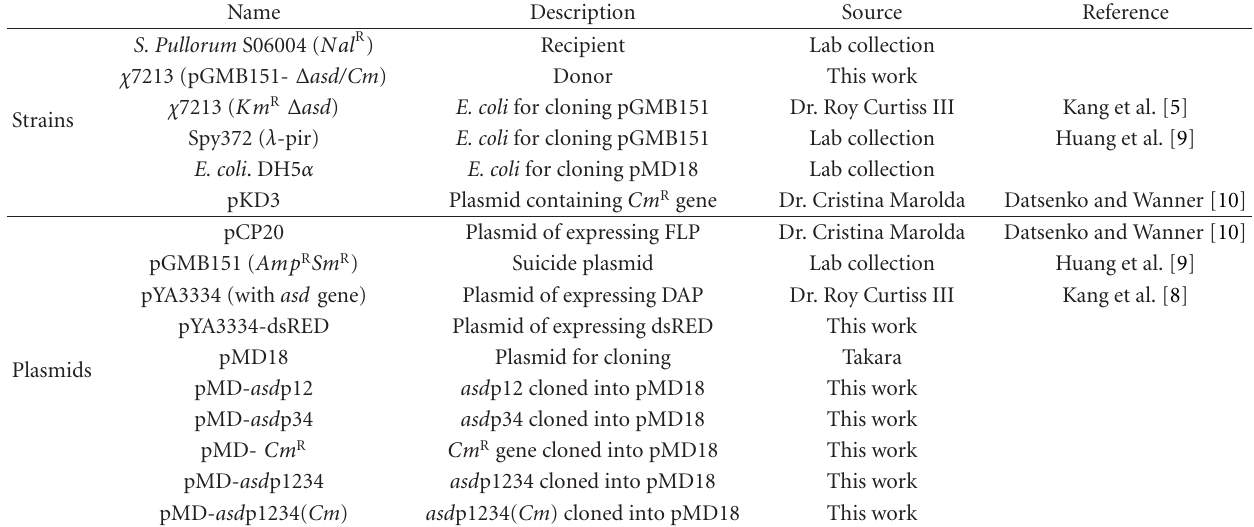
Table 1: Strains and plasmids used in this study.